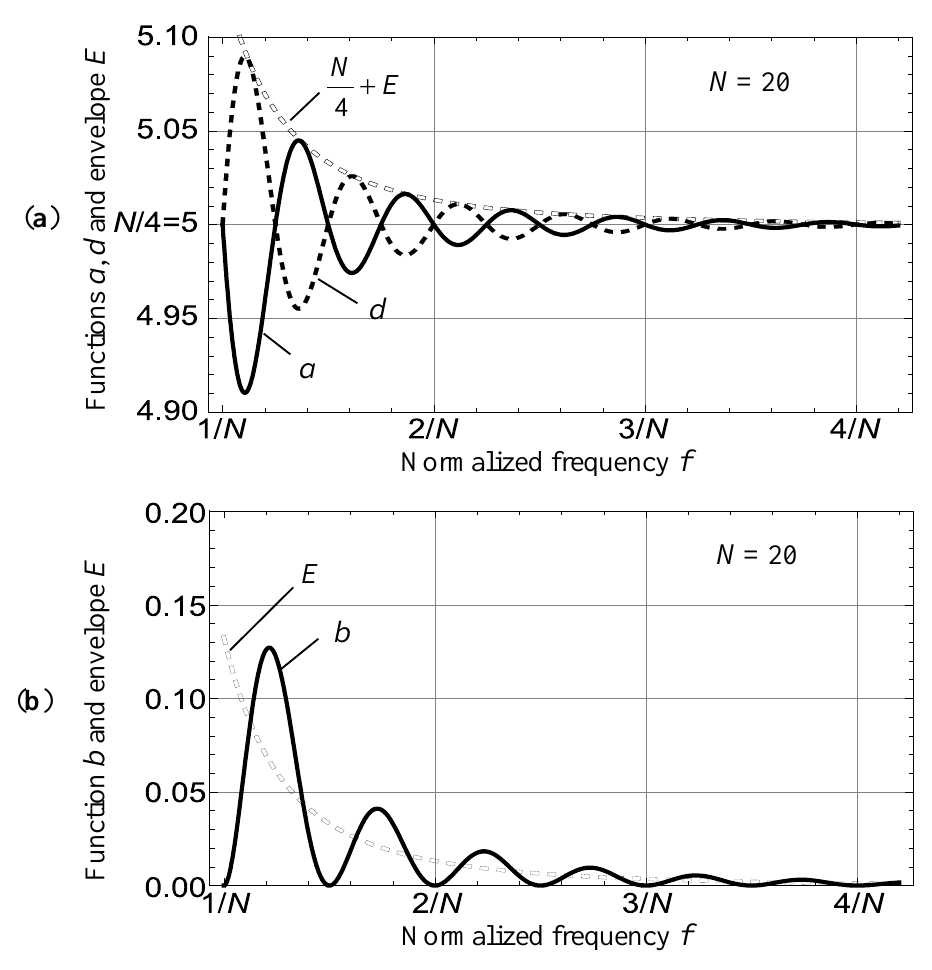
Figure 3. AC leakage gains of Equation (2) as functions of the normalized frequency f above f = 1/ N ( a ) matrix elements a and d and ( b ) matrix element b